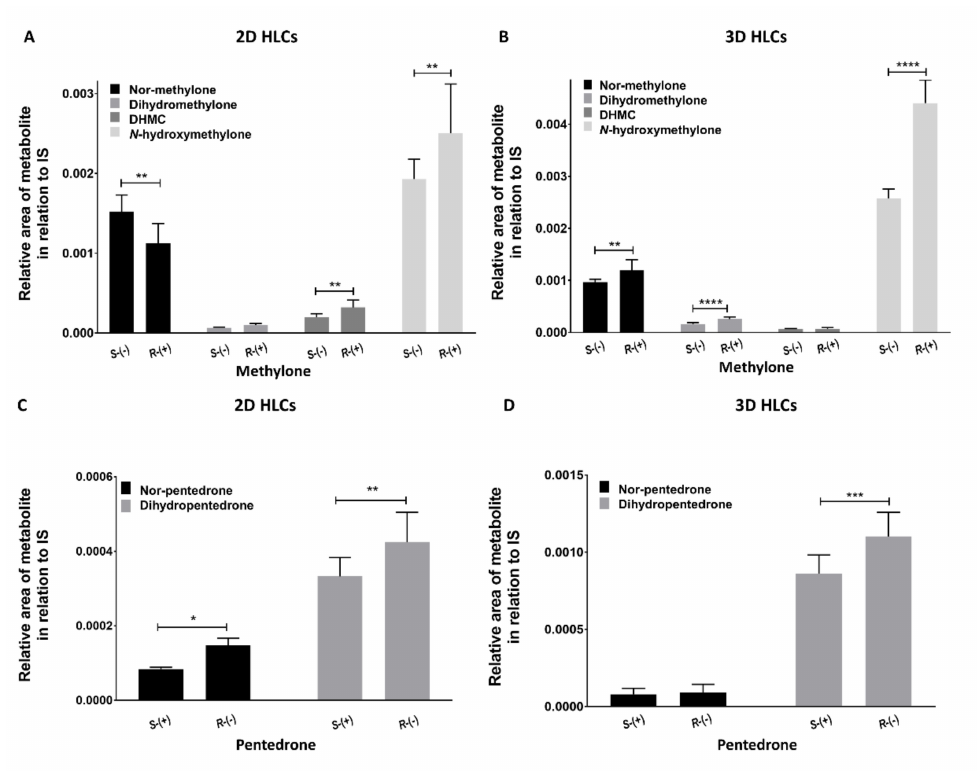
Figure 10. Metabolic profile of ( A ) methylone in 2D-HLCs, ( B ) methylone in 3D-HLCs, ( C ) pentedrone in 2D-HLCs, and ( D ) pentedrone in 3D-HLCs after 6 h of exposition. Data are presented as average ± SD ( n = 2). * p < 0.05, ** p < 0.01, *** p < 0.001, **** p <